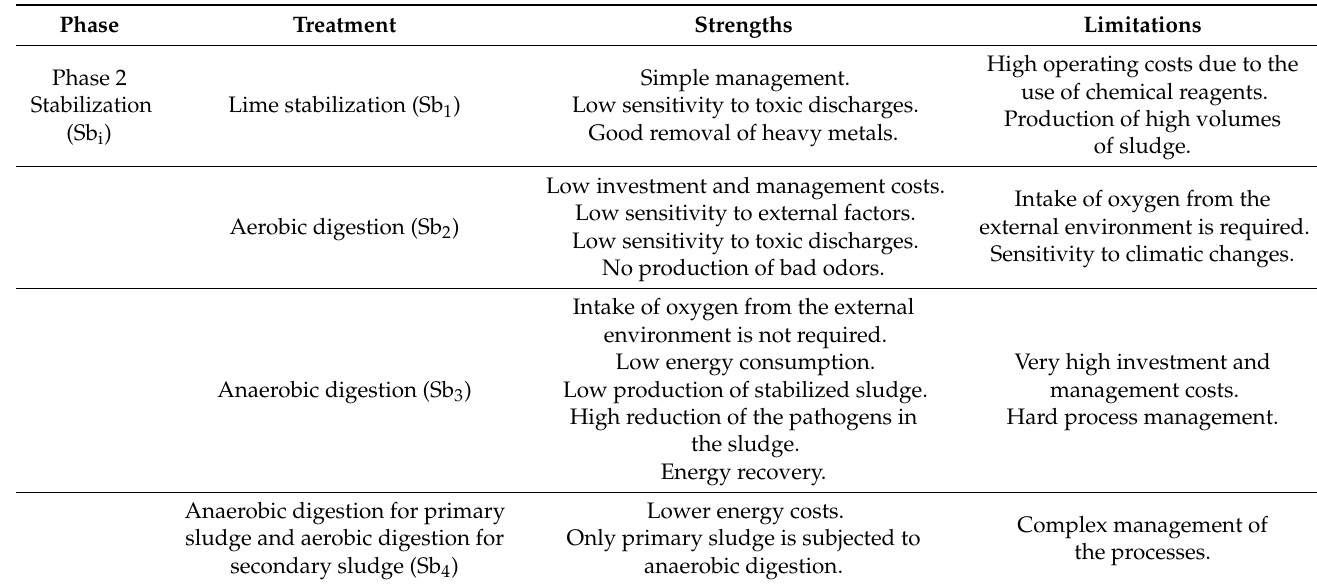
Table 3. Strengths and limitations of all considered alternatives to carry out the stabilization treatments of the modeled SSTS. Phase Treatment